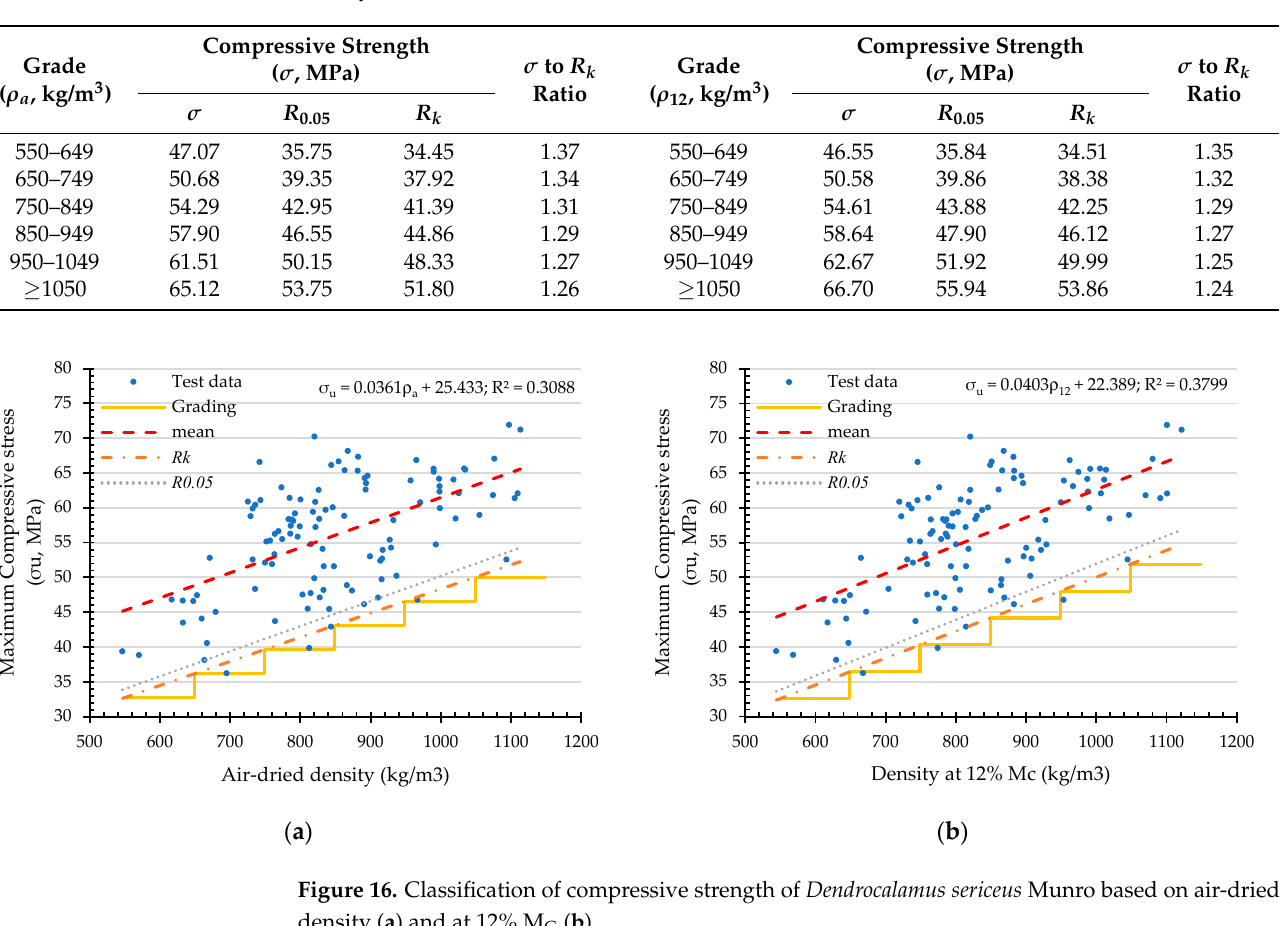
Table 5. Multiple linear regression analysis for the dependent variable maximum compressive strength ( u σ ).